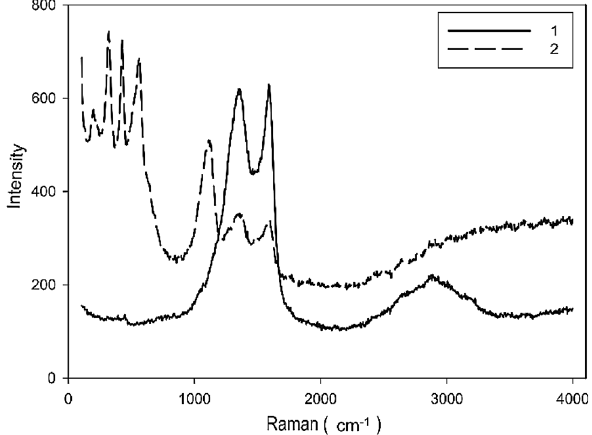
Fig. 6 Comparison of RS results for samples of solids obtained at different working